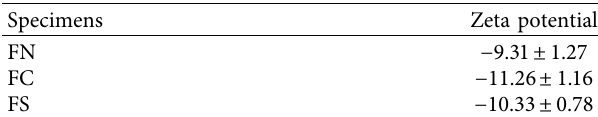
Figure 5: 2D and 3D profles of concrete surface: (a) FN, (b) FC, and (c) FS. Table 4: Surface roughness of concrete (unit: μ m). Table 5: Zeta potential (unit: